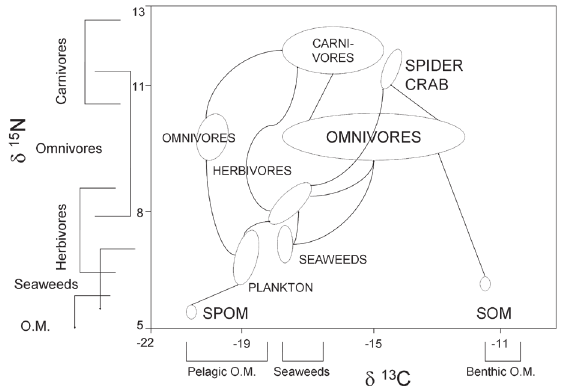
Fig . 6. – representation of the main trophic flows in the food web related to Maja brachydactyla in the Golfo artabro, from n and C stable isotope analysis. (See Fig. 5 for data). δ 13 C values for Som are corrected by a factor of -2‰ (see text for the